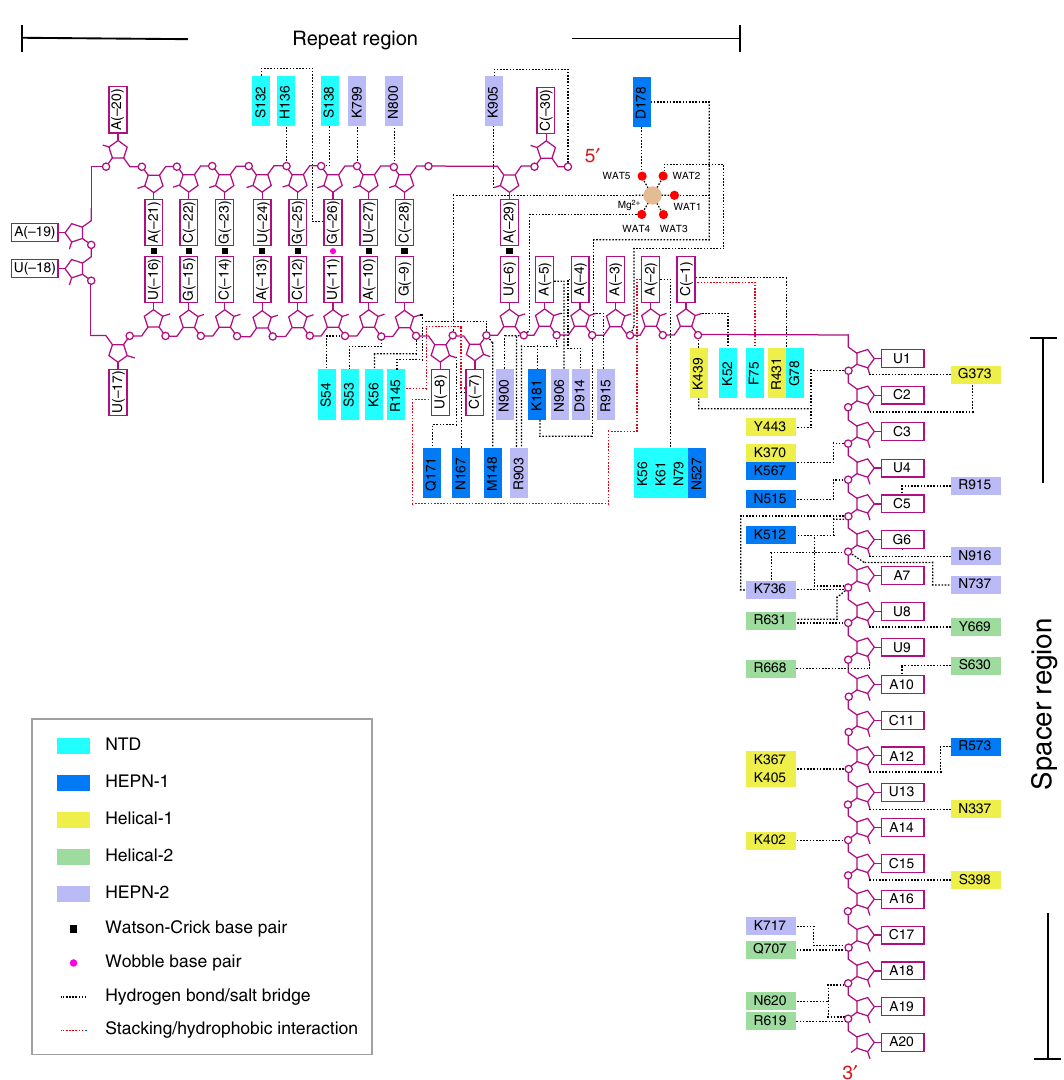
Fig. 3 Schematic of crRNA recognition by UrCas13d. Domains and residues are colored according to Fig. 1. Hydrogen bonds and salt bridges are shown as black dashed lines. Stackings and hydrophobic interactions are shown as red dashed lines. The coordinated water molecules of the Mg 2 + ion are labeled as